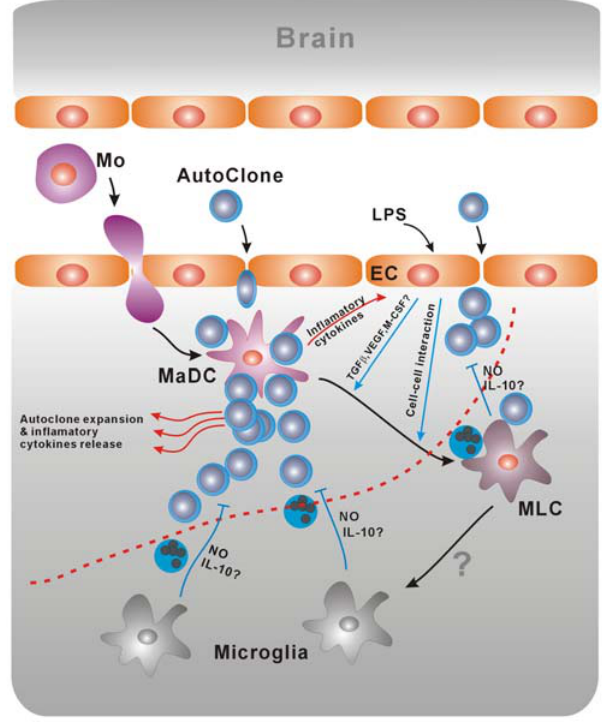
Figure 6. A model of dynamic transformation of antigen presenting cells in CNS. Some special infection in the CNS can destroy neural tissues and endothelial cells of capillary, in this status, BBB was impaired followed by the entrance of monocytes and autoreactive T cells from peripheral blood. Monocytes will become mature DCs in the stimulation of inflammation factors secreted by the infected cells, after crossing the endothelia. New mature DCs derived from monocytes will capture the antigens of neural tissue, prime autoreactive T cells and lead to immunopathological injury. On the contrary, microglia activated by the inflammation factors can secrete high level of NO to inhibit T cell proliferation, even induce T cell apoptosis. The role of IL-10 secreted by microglia in the inhibitory function remains to be investigated. The infiltrated dendritic cells after priming might become inhibitory microglia like cells or microglia under the sustained influence of microenvironment. The cell-to-cell interac- tion played a key role in the differentiation of DC. The effects of TGF- b , M-CSF, VEGF secreted by activated endothelial cells remain to be investigated. Whether MLC will differentiate into microglia is unknown. Microglia and the transformation from priming dendritic cells to inhibitory microglia like cells and even microglia contribute to the remission of the autoimmune diseases of CNS.